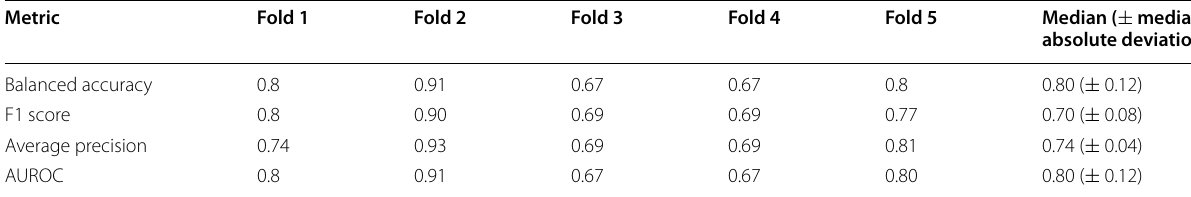
Table 2 Median ( median absolute deviation) values for metrics obtained during a 5-fold stratified cross-validation evaluation of the ± decision tree classifier in the derivation cohort